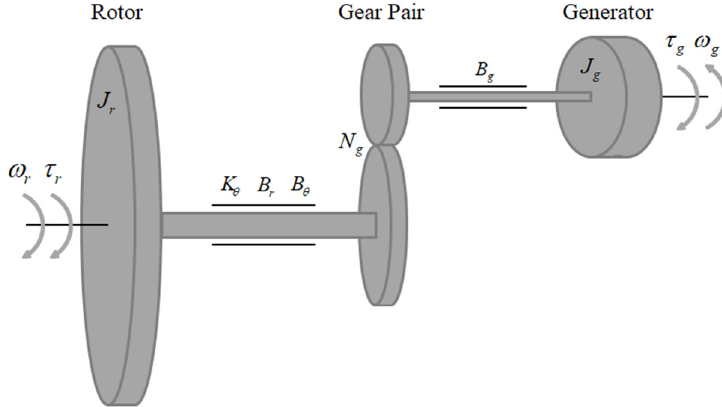
Figure 1. Mathematical model of wind turbine.